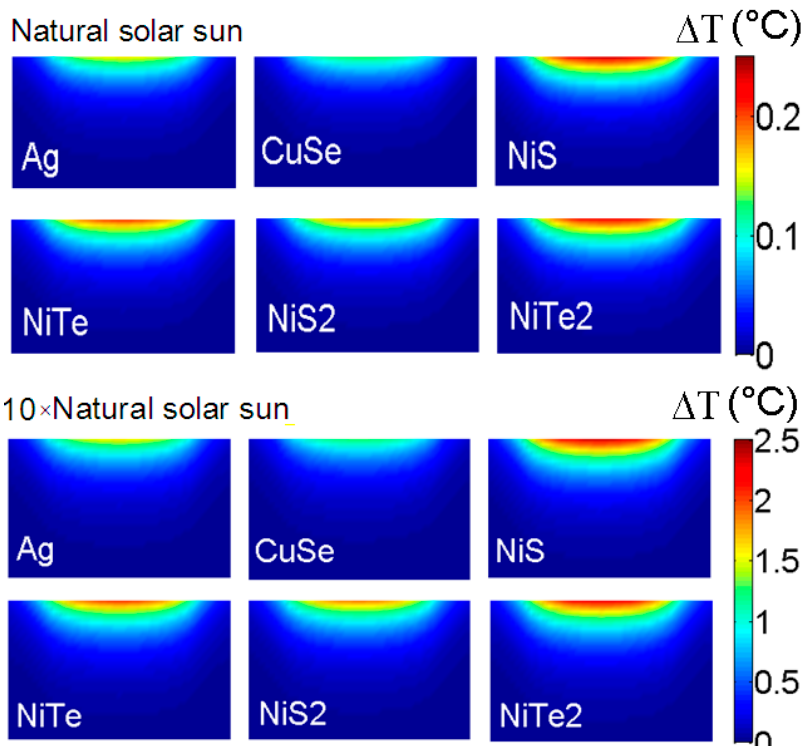
Figure 5. The temperature rise profile of PVDF membrane under solar radiation ( λ = 400 − 800 nm) with two different intensities. The temperature rise of PVDF membrane loaded with NiS and NiTe2 NPs reaches 0.25 °C and 2.5 °C (at the membrane surface center) under natural solar sun radiation and its amplified intensity, respectively.